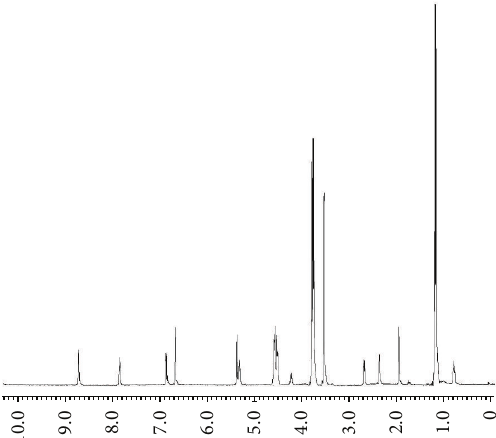
Figure 5: 1 H NMR spectra of PUEAF25.